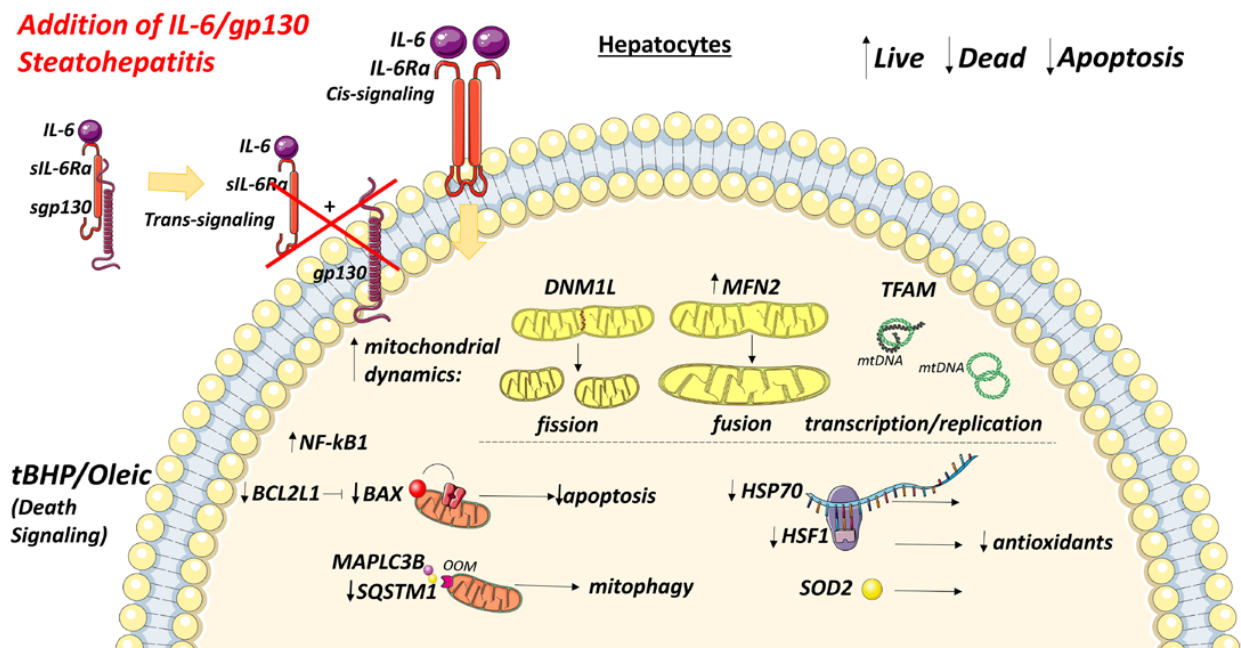
Figure 9. Visualization of the results of the study of cis- and trans-signaling of IL-6 in cellular models of steatohepatitis. The addition of IL-6 increased the expression of mitochondrial dynamics genes ( MFN2 and TFAM ), and decreased the expression of the mitochondrial division gene ( DNM1L ) and apoptosis marker genes ( BCL2L1, BAX ), which led to an increase in the percentage of living cells in the steatohepatitis model. The addition of gp130 increased the expression of the mitochondrial fusion gene ( MFN2 ), and decreased the expression of apoptosis ( BCL2L1, BAX ) and mitophagy ( SQSTM1 ) marker genes, which led to an increase in the percentage of living cells in the steatohepatitis model. Addition of IL-6 or gp130 reduced the expression of cytoprotector genes ( HSF1 and HSP70 ) in HepG2 cell cultures with tBHP/Oleic.